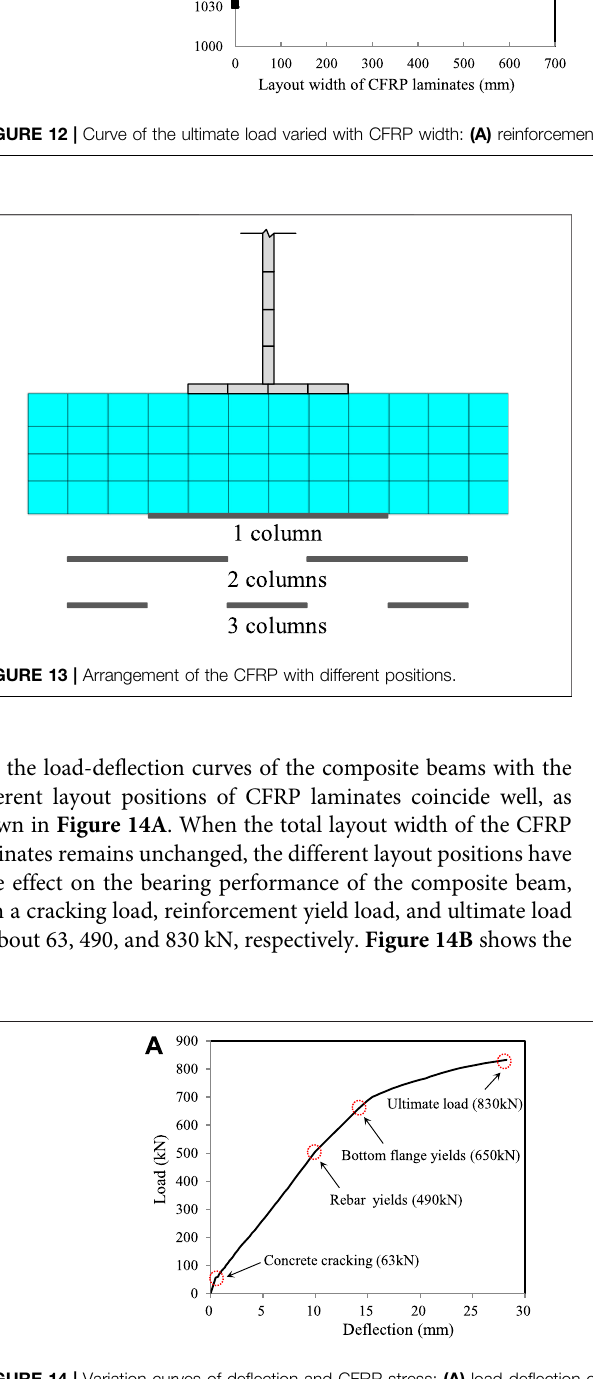
Frontiers in Materials |